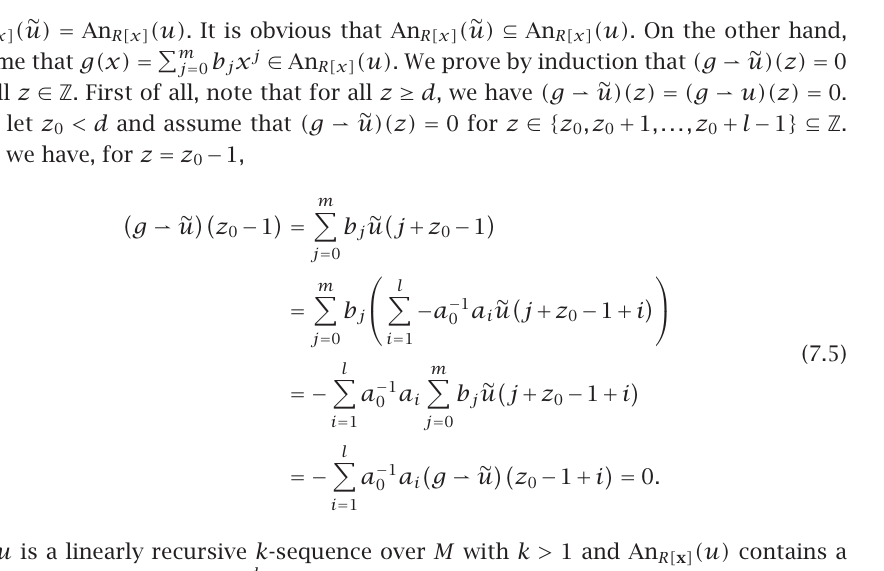
Table 7.1 lists some of the terms of the bisequence Rev ( (cid:1) ) ∈ An (cid:31) (cid:3)